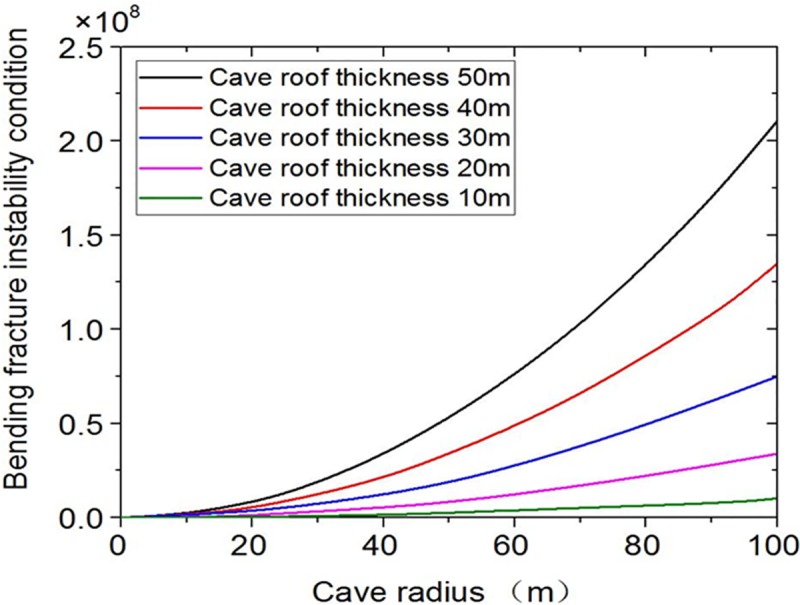
Influence curves of different cave roof thickness.